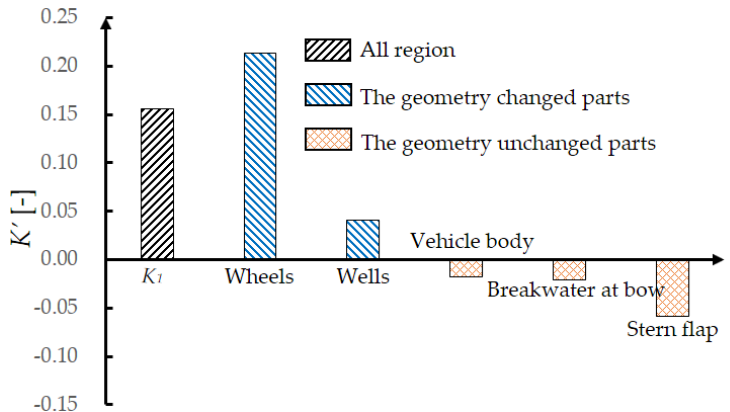
Figure 12. The resistance variation of each part of the vehicle at Fr = 0.624.